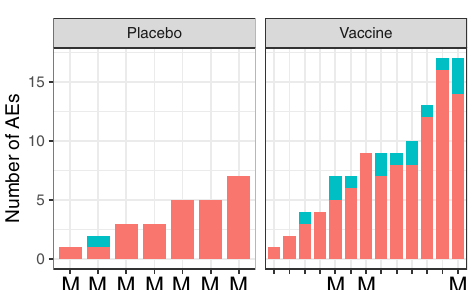
In square brackets: number of events; number of patients with events; in brackets: percentage of patients with event. No differences were statistically signi fi cant ( p >0.10, Fisher ’ s exact test, two-sided for all).